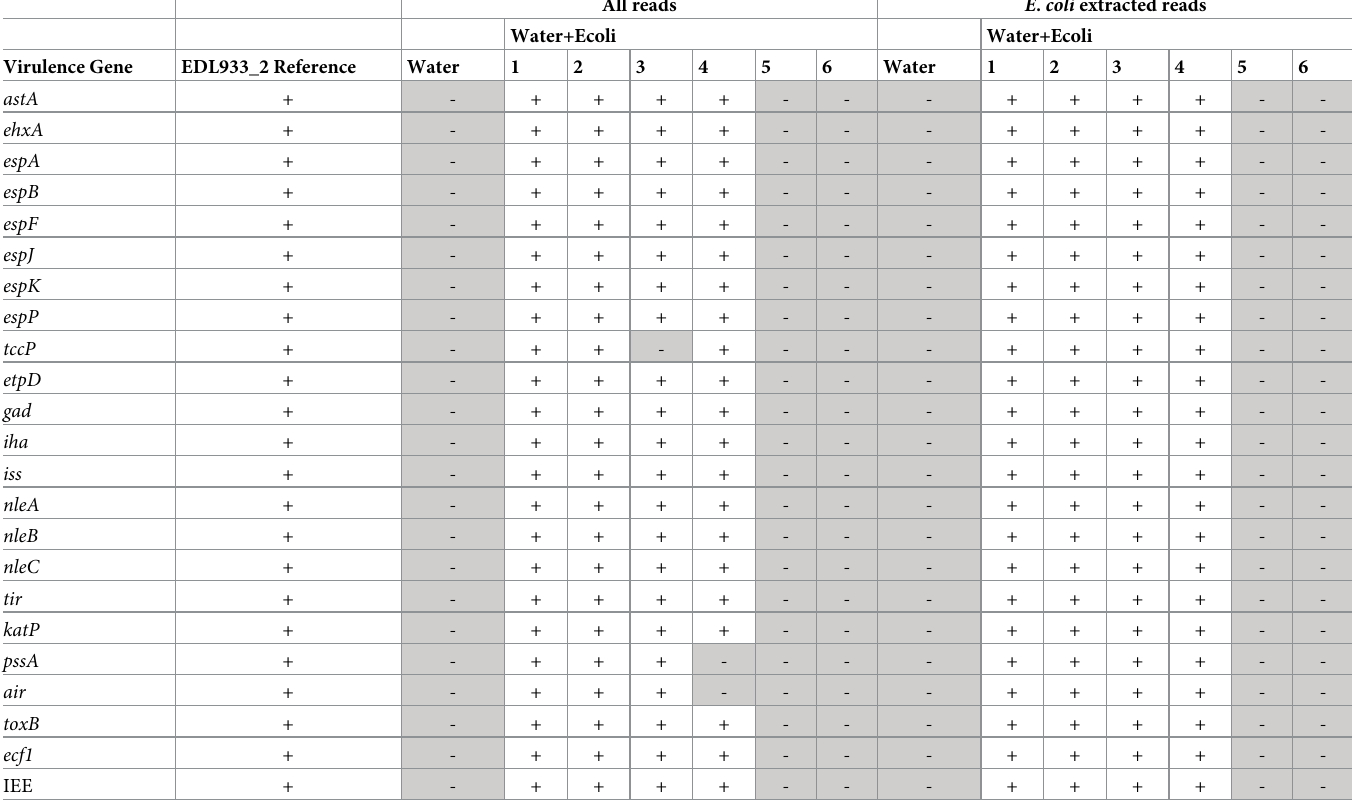
Table 4. In silico detection of virulence genes in Flye assemblies with all nanopore reads and E . coli extracted